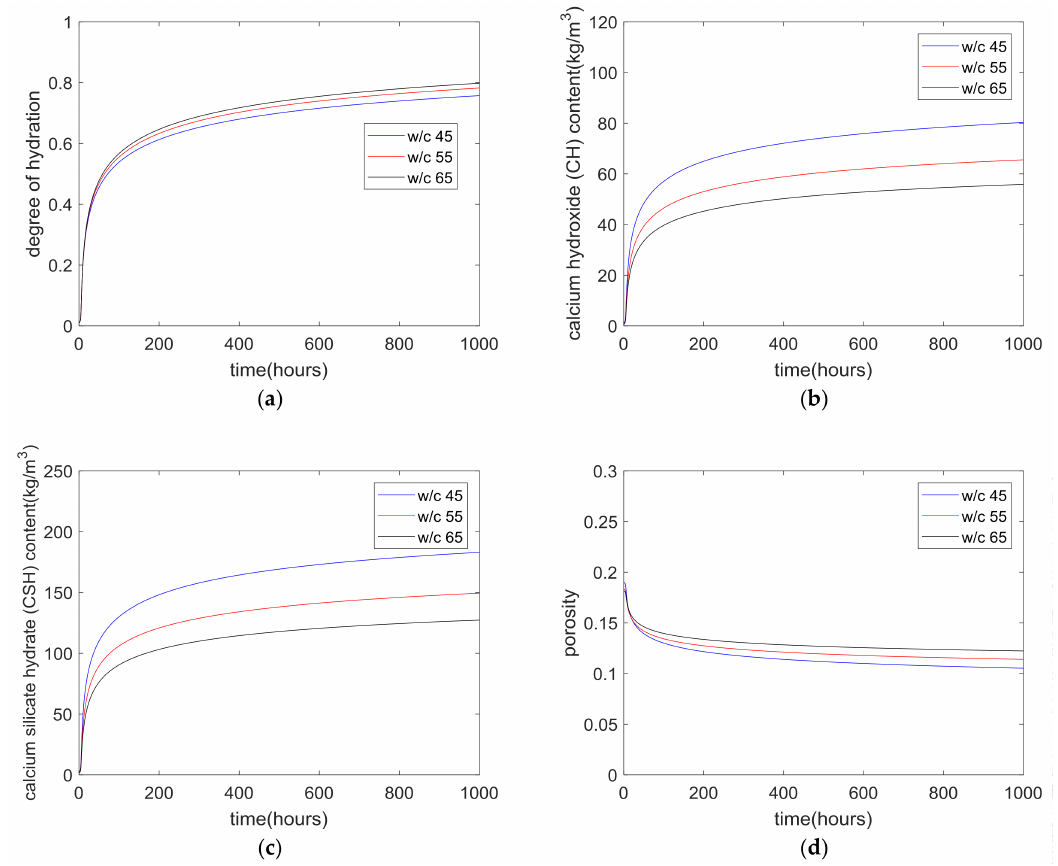
Figure 2. Hydration related properties of concrete. ( a ) degree of hydration; ( b ) CH content; ( c ) CSH content; ( d ) porosity of